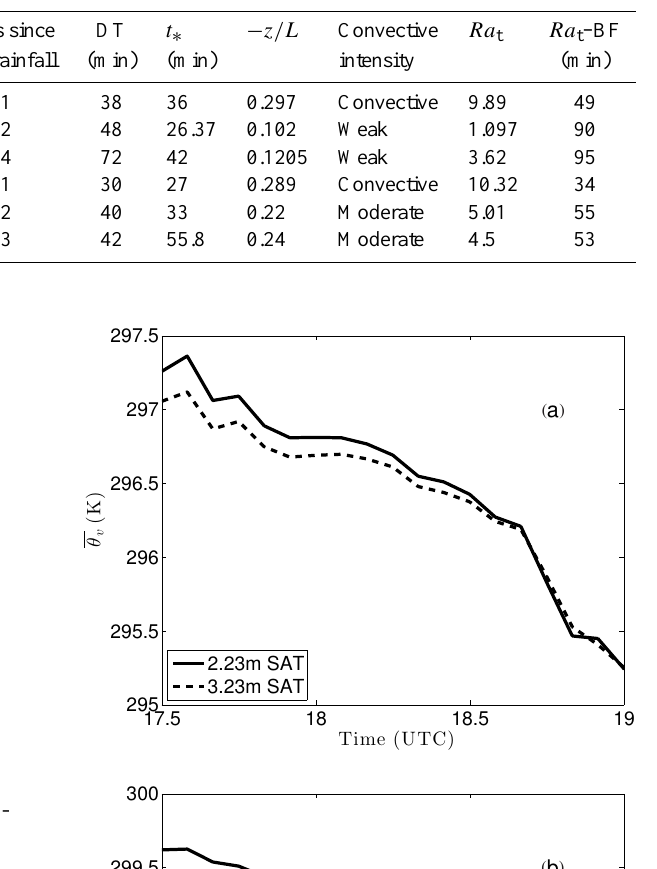
Table 1. Based on the observations taken during the BLLAST campaign, IOP day, maximum sensible heat flux (SH max ) , length of the day, days since last rainfall, delay time, convective timescale, convective intensity, transitional turbulent Rayleigh number and temporal difference between the time when Ra and buoyancy flux change sign.